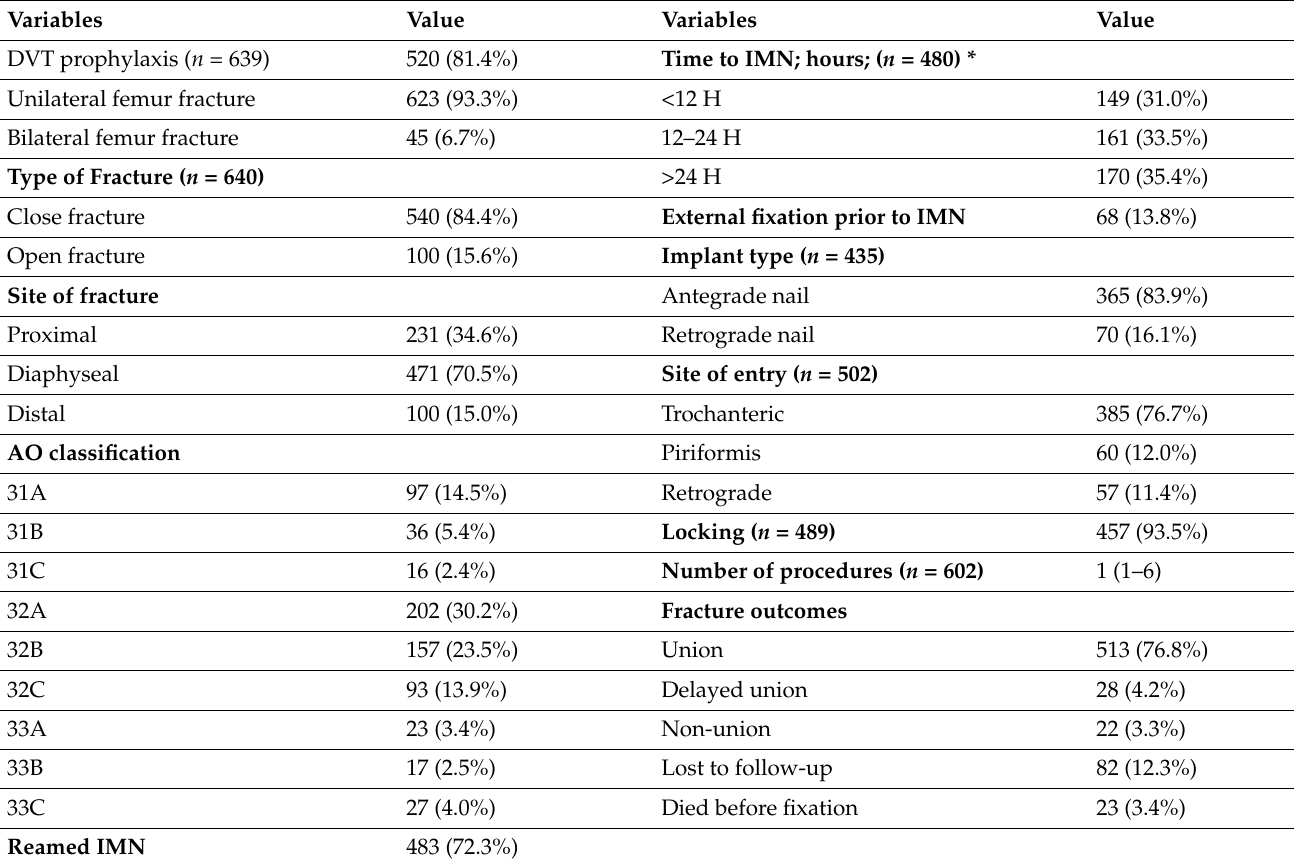
Table 2. Presentation and management of femur fracture cases.